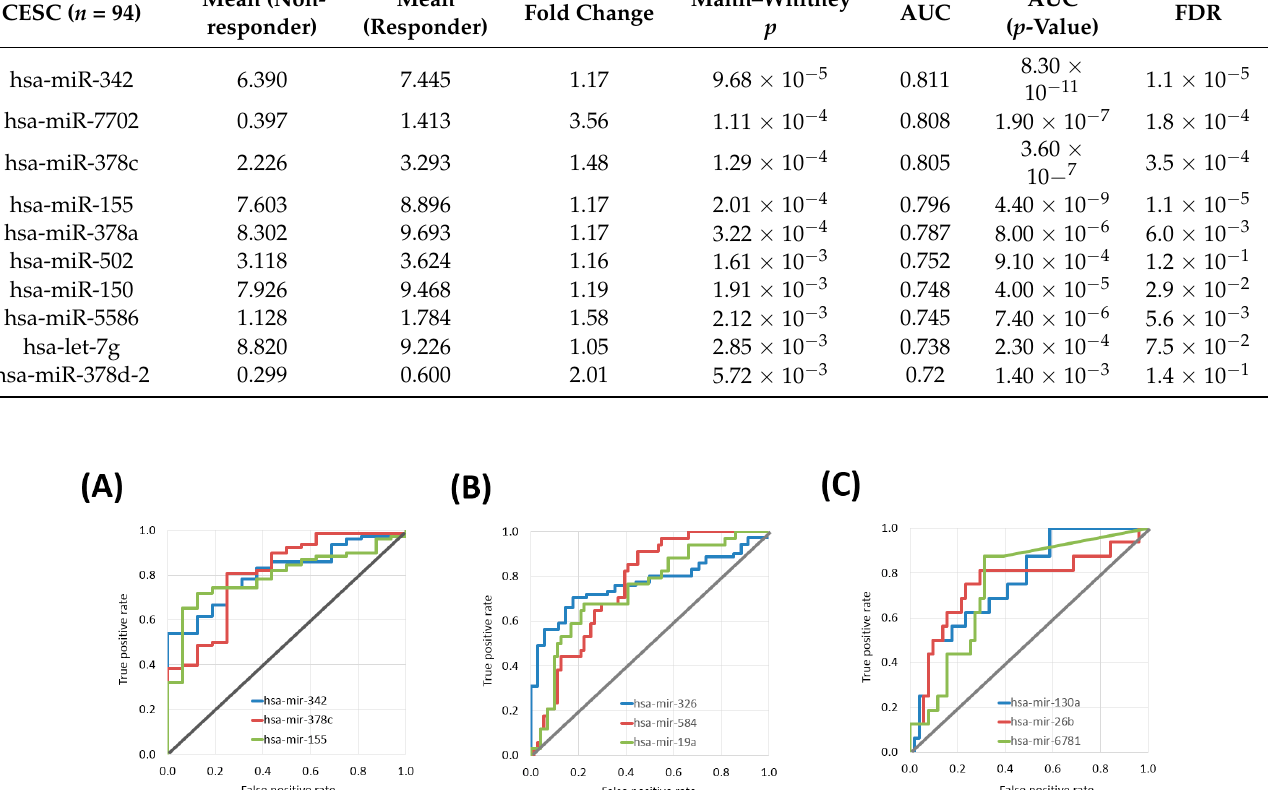
Table 2. Top ten miRNA biomarker candidates of platinum-based therapy in cervical cancer (CESC). CESC ( n = 94)